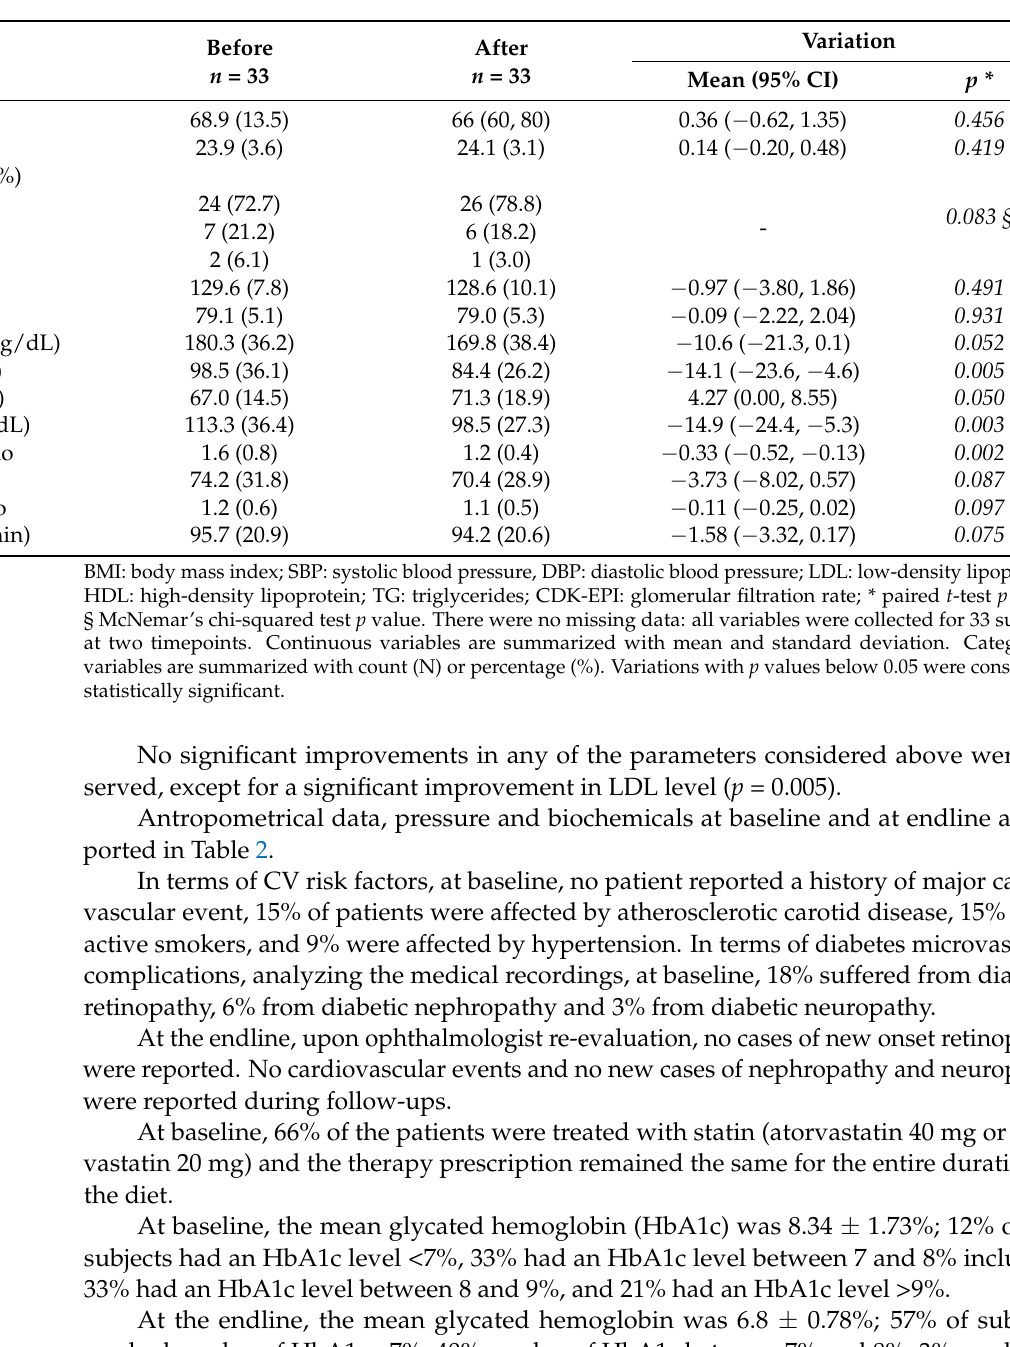
Table 2. Clinical and biochemical data of the patients before and after the